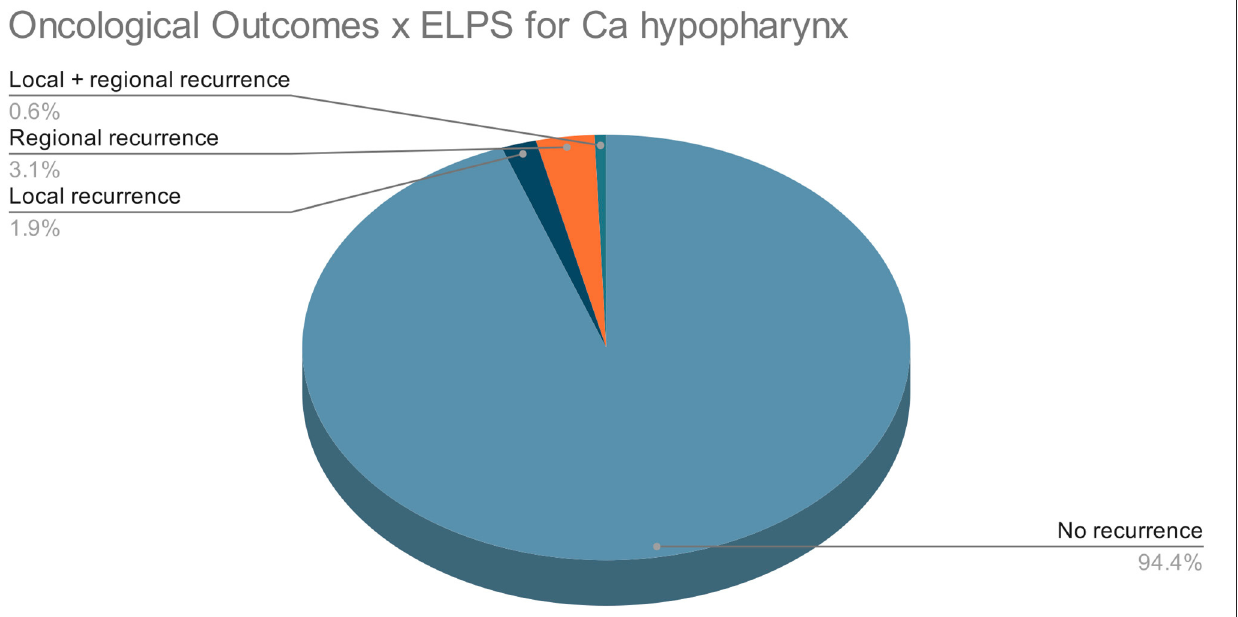
FIGURE 7 | Oncological outcomes in ELPS